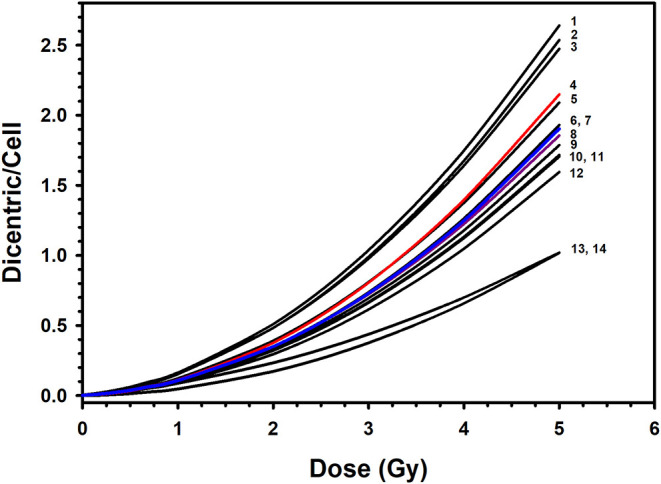
Comparison of the published dose–response calibration curves of dicentric chromosome aberrations induced by X-rays: 1. Germany, 90 kVp at 0.1 Gy/min (in (26); 2. Italy, 100 kVp at 1 Gy/min (30); 3. Canada, 250 kVp (29); 4. Preliminary dose–response curve in Saudi Arabia, 320 kVp at 1.33 Gy/min (20); 5. Germany, 250 kVp at 1 Gy/min (in (26); 6. The Netherlands, 100 kVp at 0.4 Gy/min (31); 7. Saudi Arabia, this study, 320 kVp at 1 Gy/min; 8. England, 250 kVp (28); 9. Germany, 240 kVp at 1 Gy/min (26); 10. Serbia, 250 kVp (33); 11. Germany, 220 kVp at 0.5 Gy/min (34); 12. Spain, 180 kVp at 0.27 Gy/min (in (26); 13. United States, 250 kVp at 1 Gy/min (32); 14. Indonesia, 122/250 kVp at 0.17 Gy/min (19).